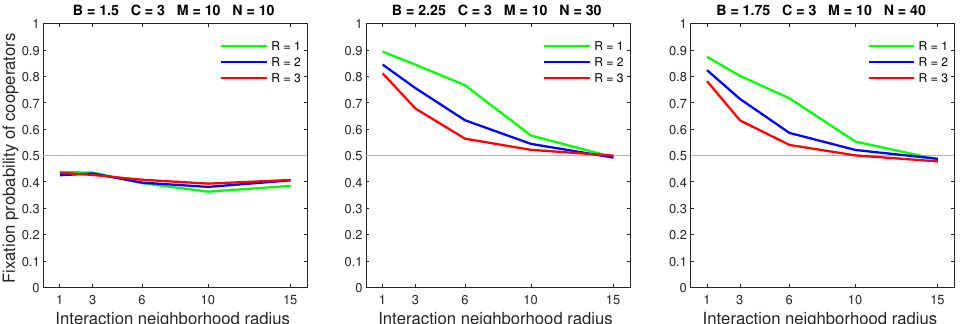
Figure 15. In the deterministic dispersal model, increasing the dispersal range for a high mobility rate ( M = 10) only has a negative effect on cooperators in dense